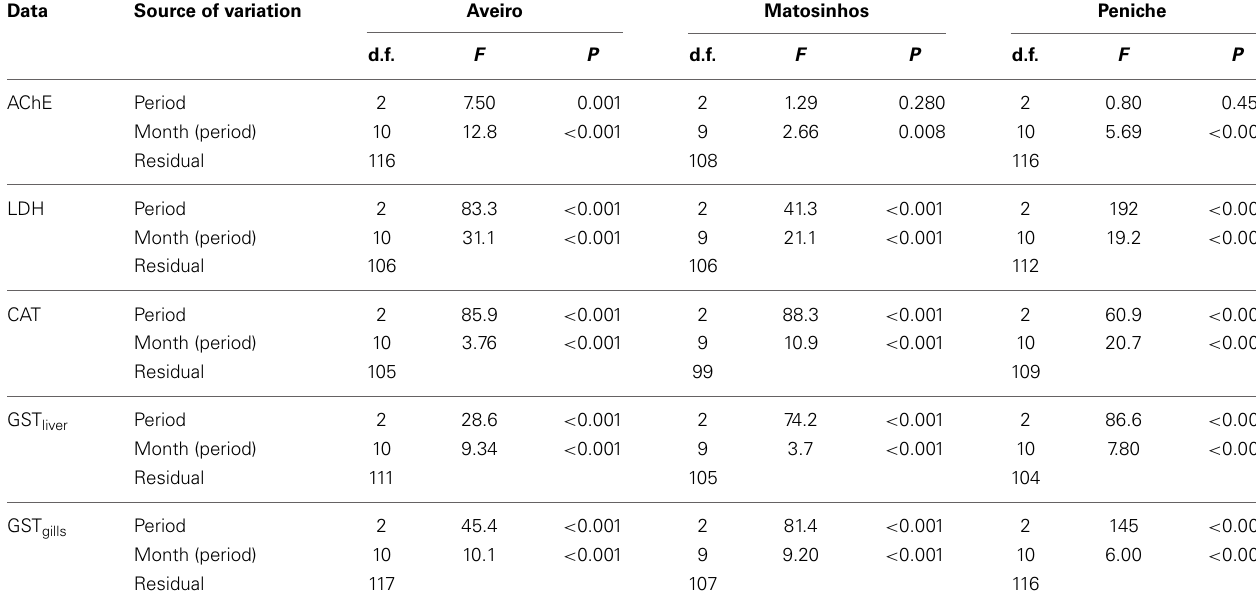
Table 2 | Summary of nested ANOVA on biomarker data across periods (feeding, reproduction, post-spawning), showing the degrees of freedom (d.f.), variance (MS), F- test and corresponding P-